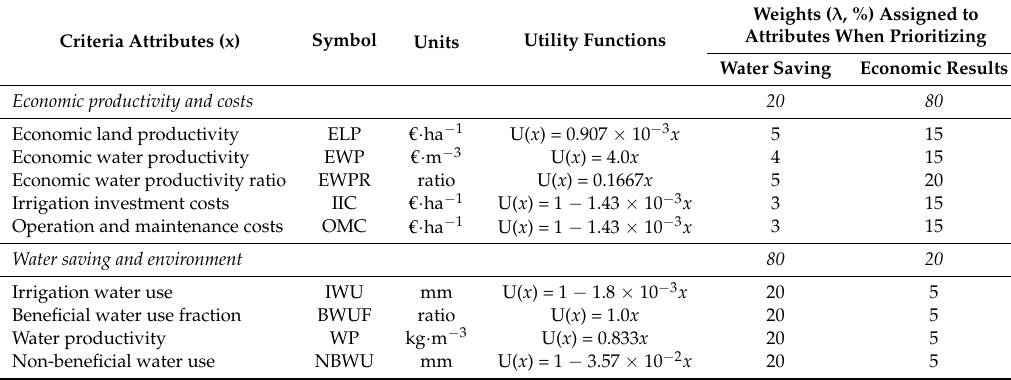
Table 5. Criteria attributes, utility functions and weights used to compare global utilities and to build prioritization